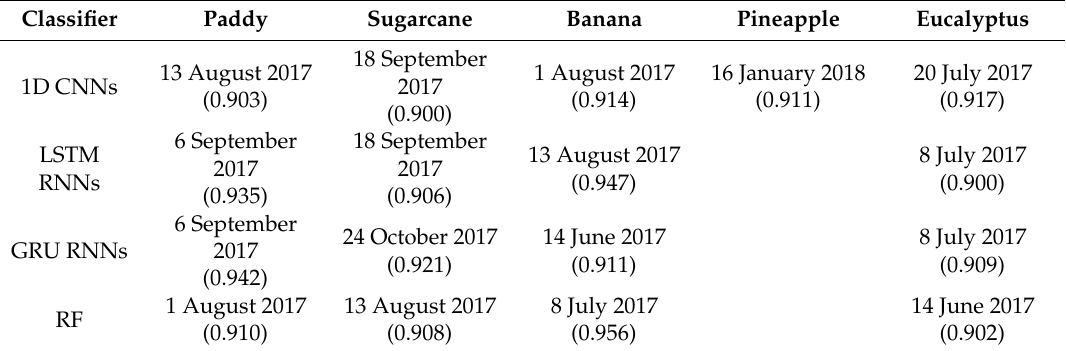
Figure 16. F-measure time series of random forest.